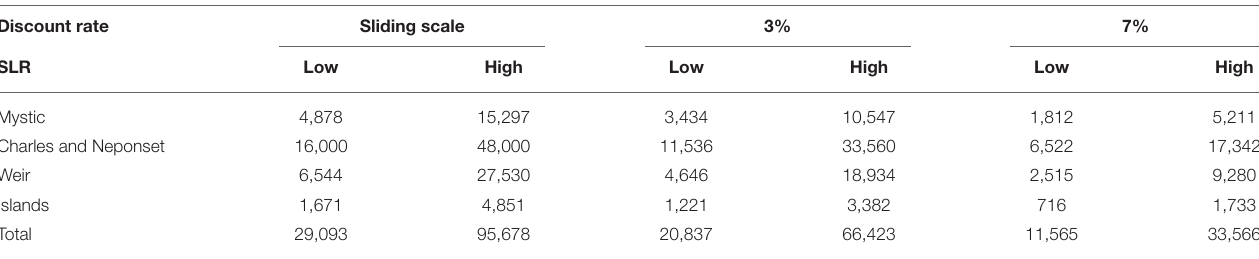
TABLE 4 | Asset value of ecosystem services (2016 $